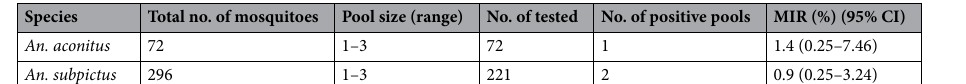
Table 1. Summary of the screening of P. caprae in anopheline mosquitoes collected from goat farms. A total of 3 pools of anopheline mosquitoes were positive using PCR assays targeting the cytb , cox1 and 18S rRNA genes. The number of pools used for species identification was also indicated.